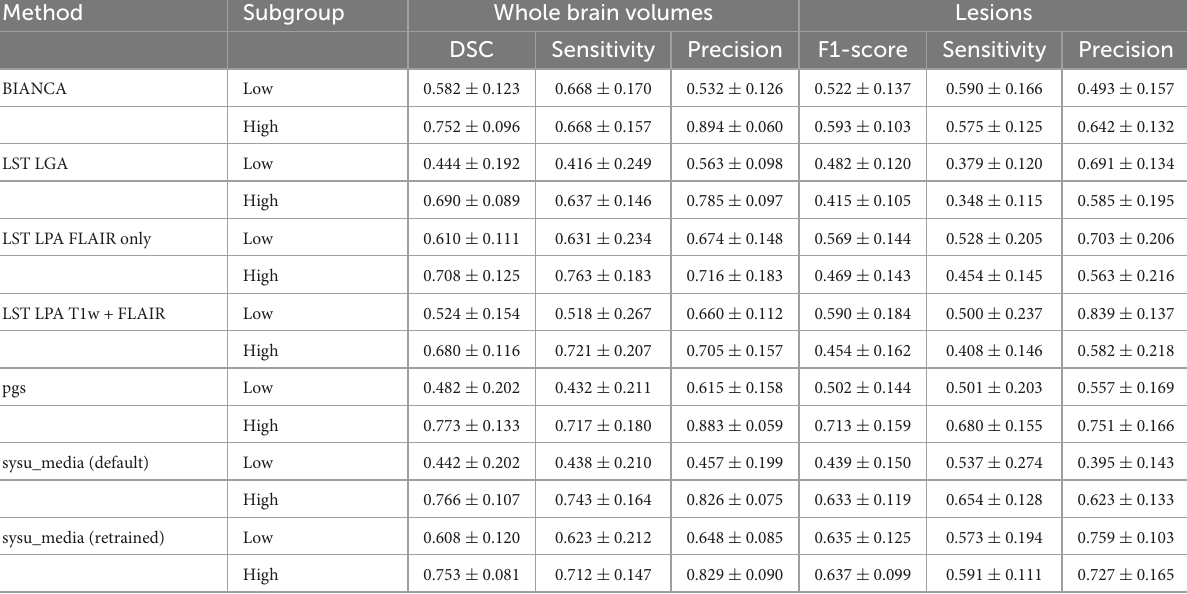
TABLE 4 Performances of all algorithms in the subgroups based on WMH load (10 subjects with lowest vs. 10 subjects with highest) compared to the reference segmentation at volume- and lesion-